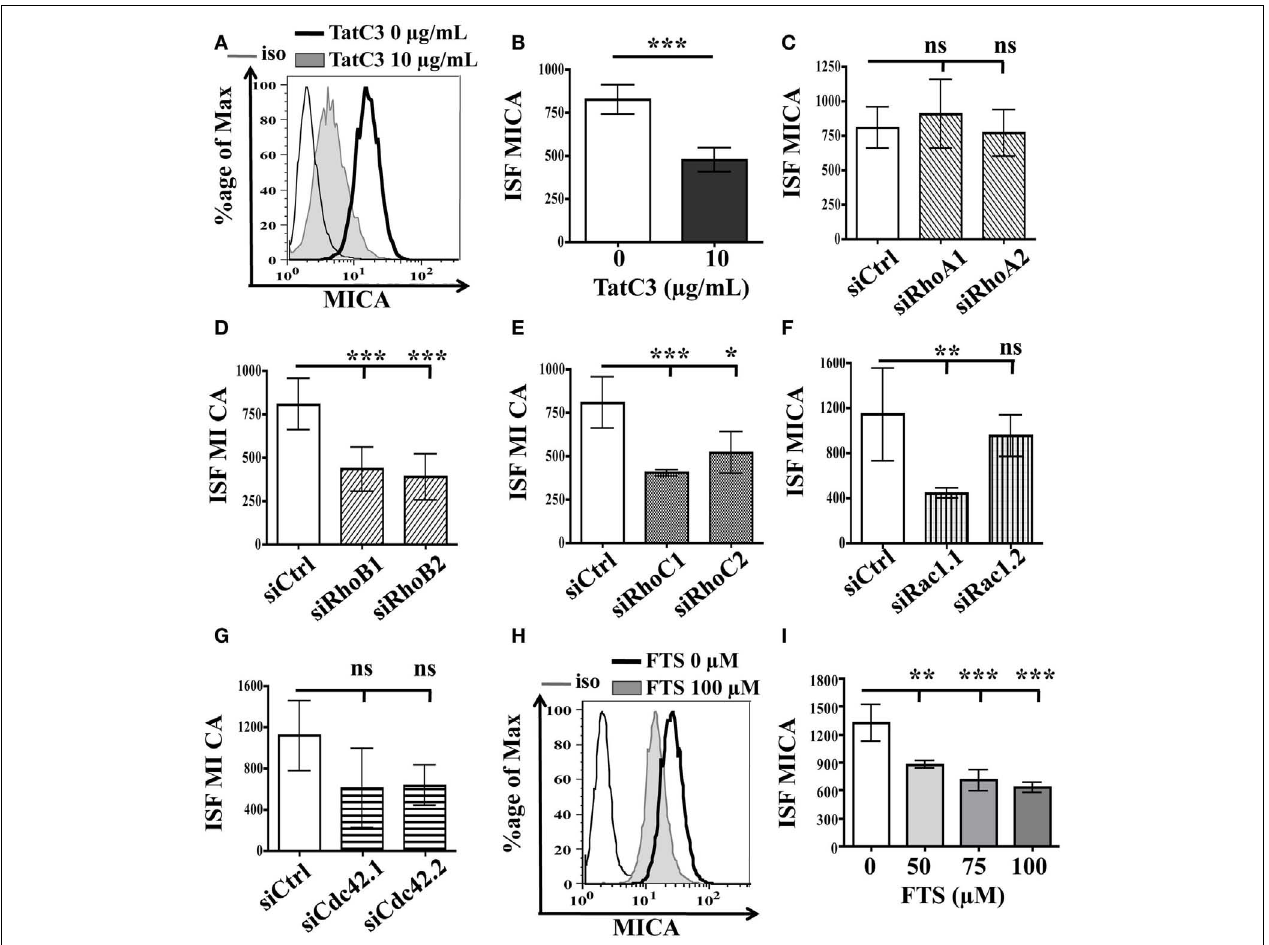
MICA membrane expression was analyzed by flow cytometry 72h after transfection or 24h after treatment. Representative illustrations of untreated cells (black) and of treated cells (filled in gray) withTat-C3 exoenzyme (A) or FTS (H) are shown.To evaluate membrane antigen expression, the index of specific fluorescence (ISF) was calculated as indicated in the Section “Materials and Methods.” Results are expressed as mean ± SD (error bars, n = 3 experiments). * P < 0.5; ** P < 0.01; *** P < 0.001 versus control condition using the Student t -test (B) or the Tukey ANOVA test (C–I)